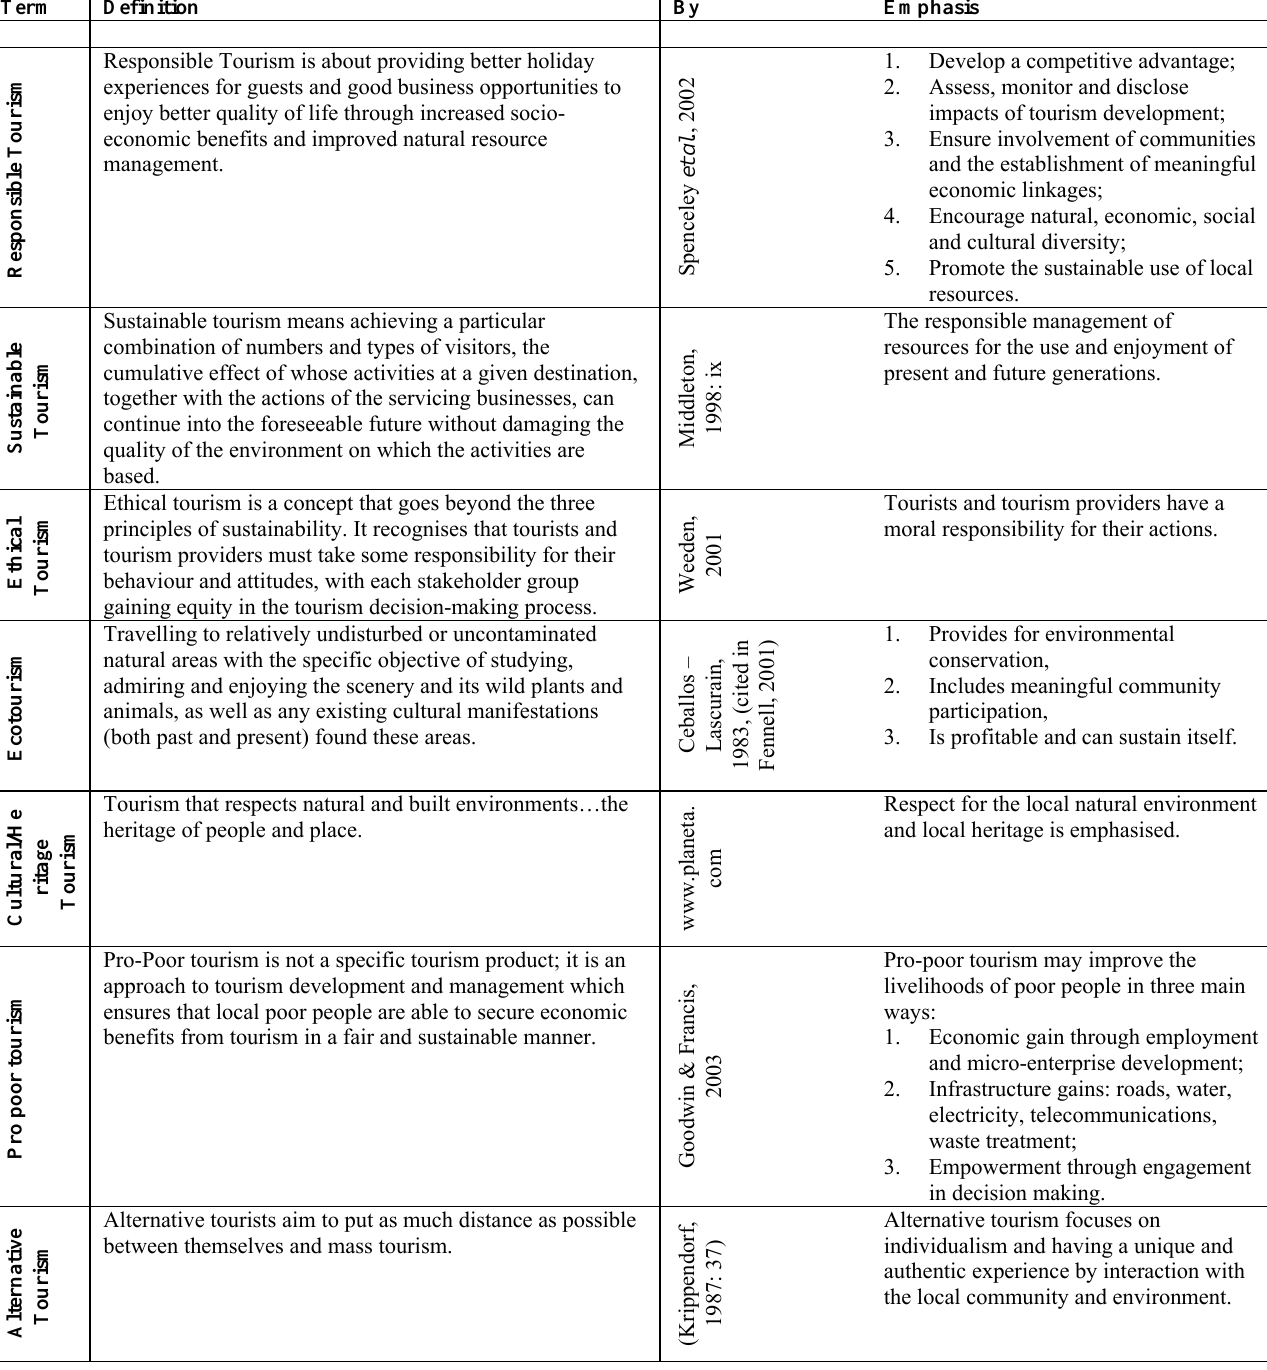
Table 1: Definition of sustainable tourism-related terms. Term Definition